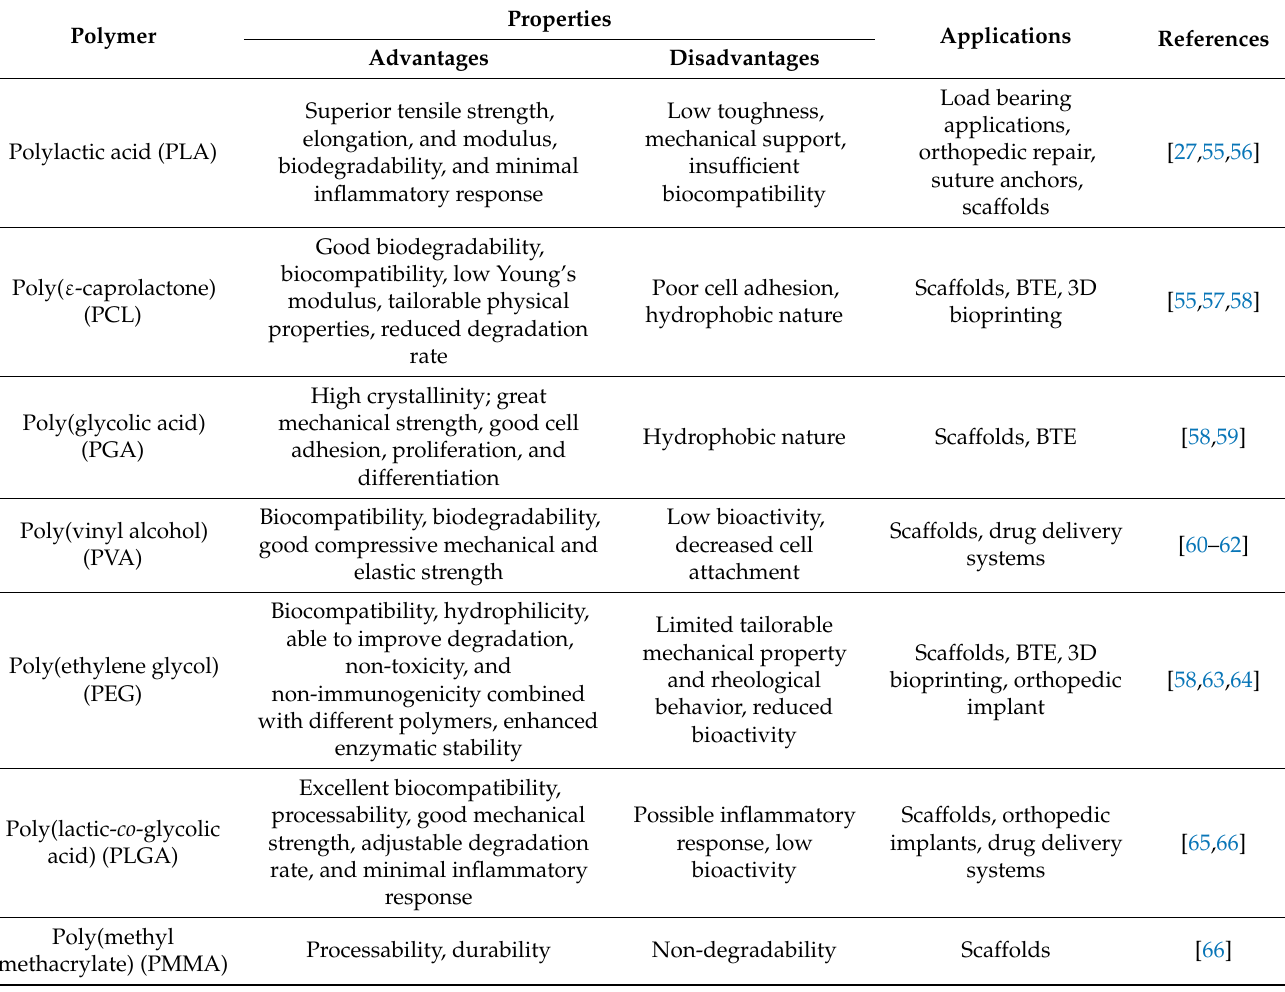
Table 2. General characteristics of synthetic polymers and their applications in